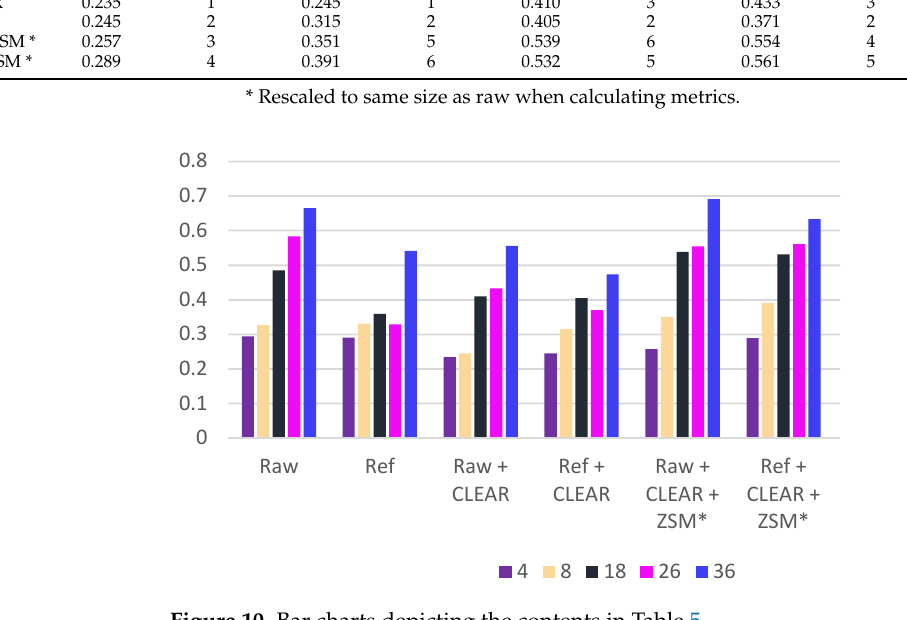
Figure 10. Bar charts depicting the contents in Table 5.